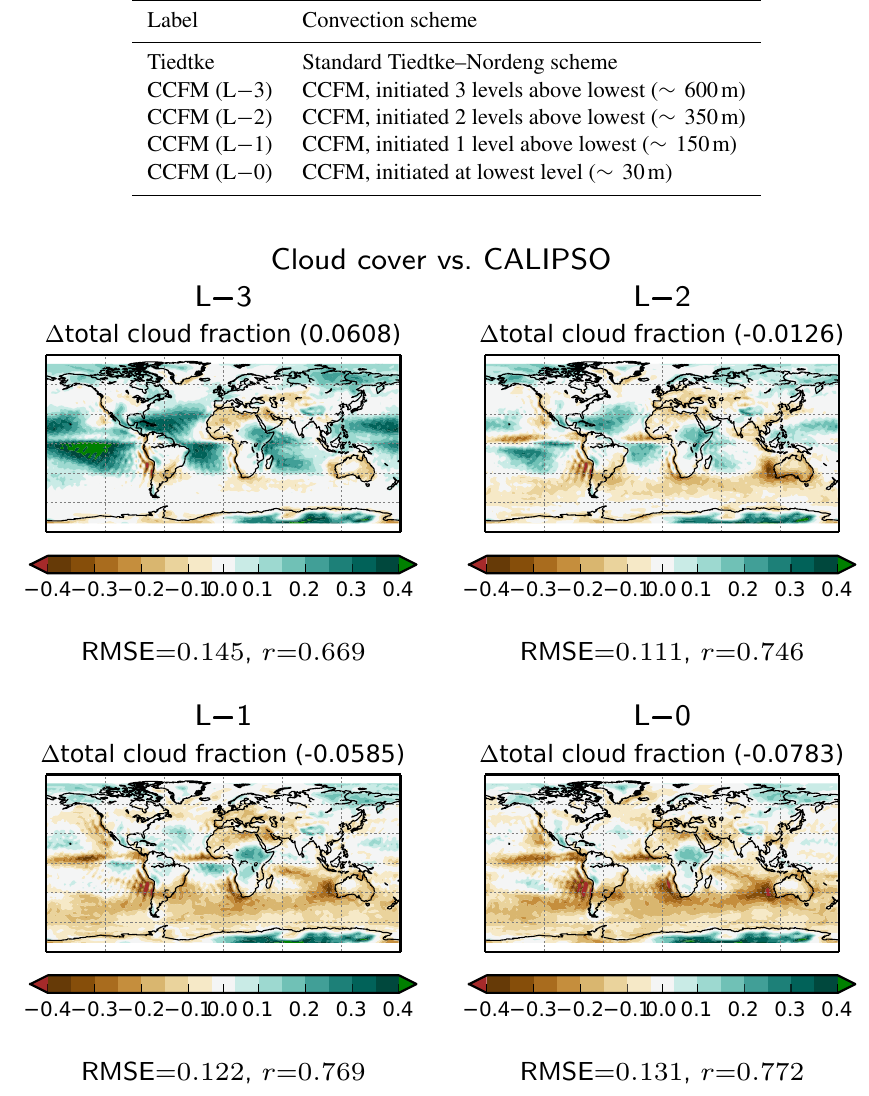
Figure 5. Difference in annual mean COSP-simulated cloud fraction between 1-year simulations using ECHAM–HAM with CCFM in each configuration and